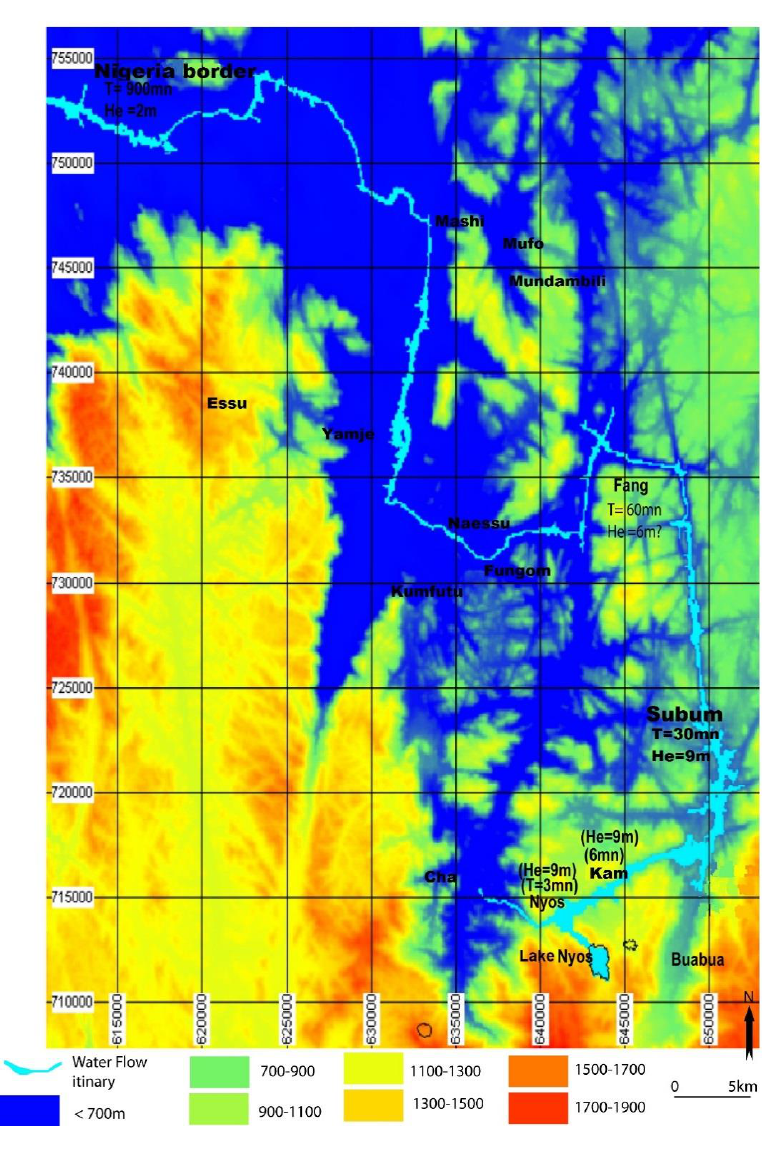
Figure 13. Simulation and calculation of flood path (Manning) in case of dam failure at Lake Nyos. (Source: report studies of the security of the Lake Nyos dam [20,59], modified.